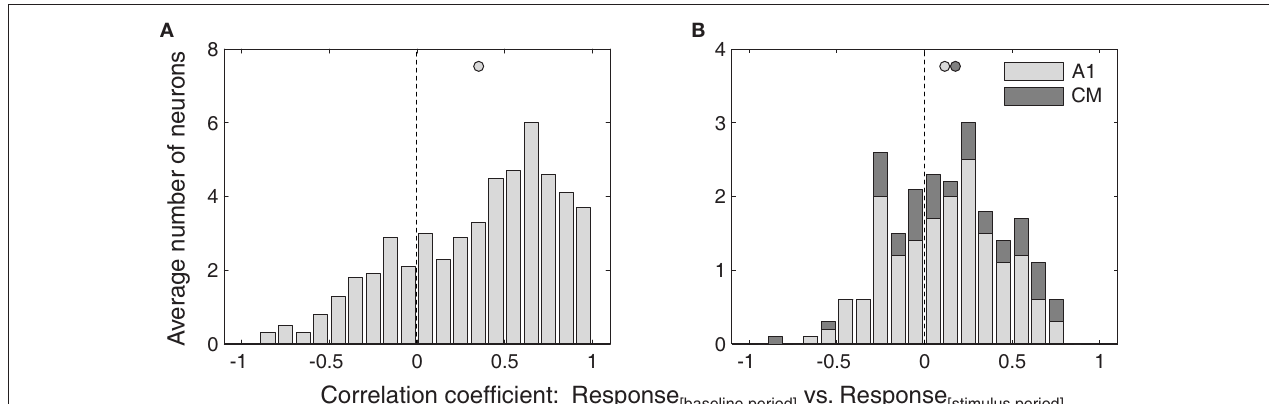
significant of eye position during either the stimulus or baseline periods. Data from inferior colliculus (A) and auditory cortex (B) are pooled across sound location. Filled circles indicate the